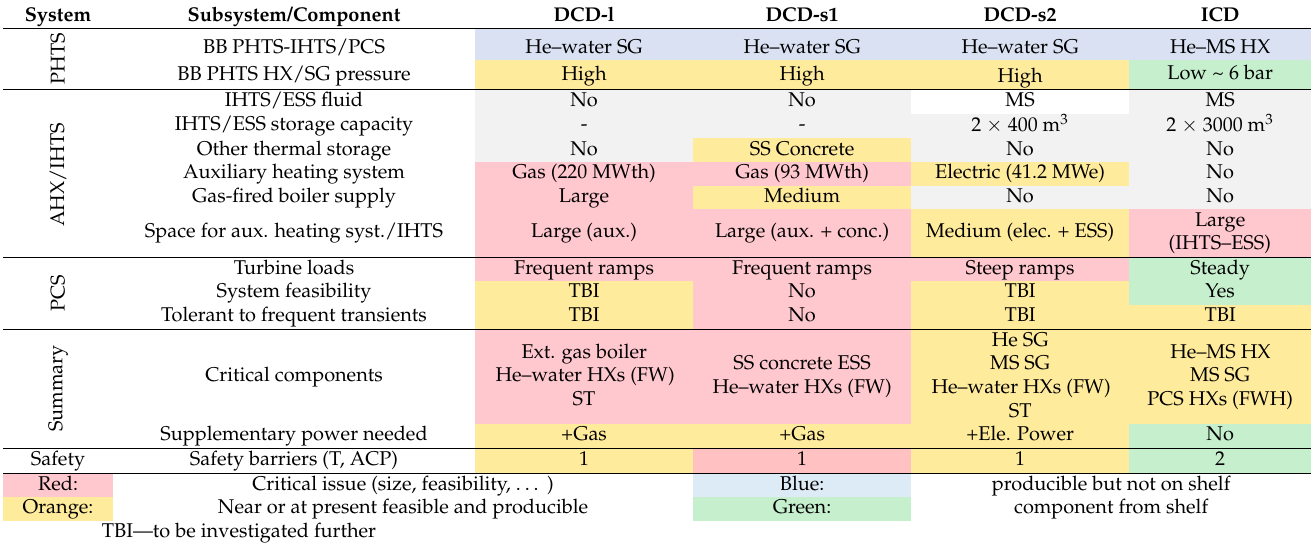
Table 2. DEMO HCPB BOP variants investigated during pre-conceptual phase [5].